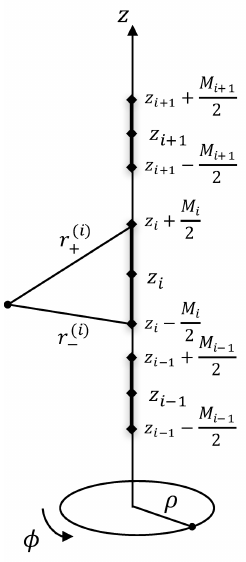
Figure 4. Schematic description of axisymmetric rod